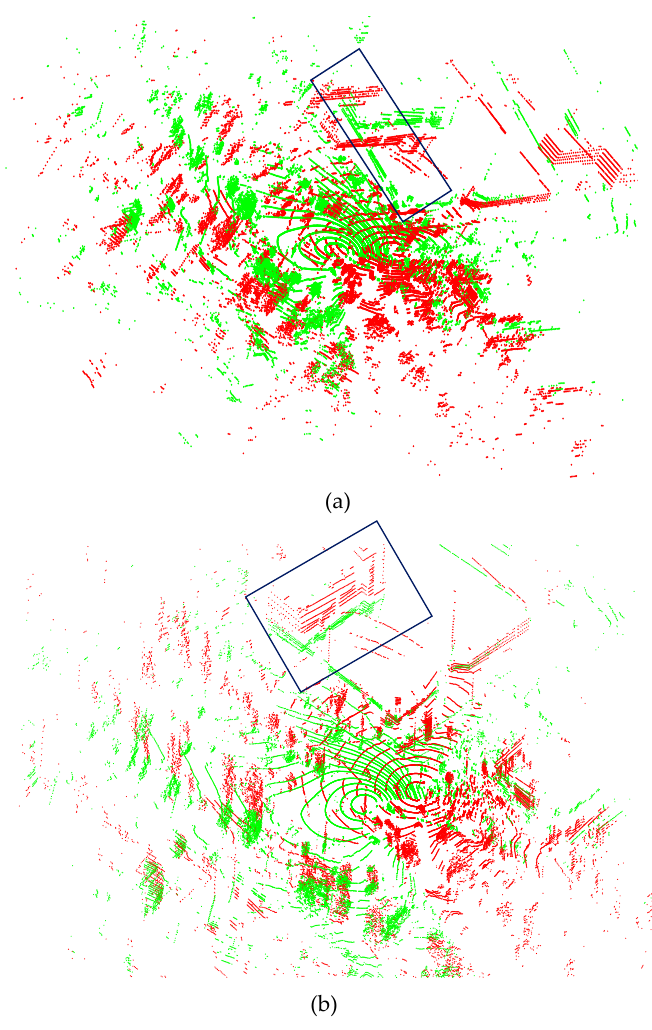
Figure 7. LiDAR data registration with the GA. ( a ) XY Plane. ( b ) Z ‐ axis.